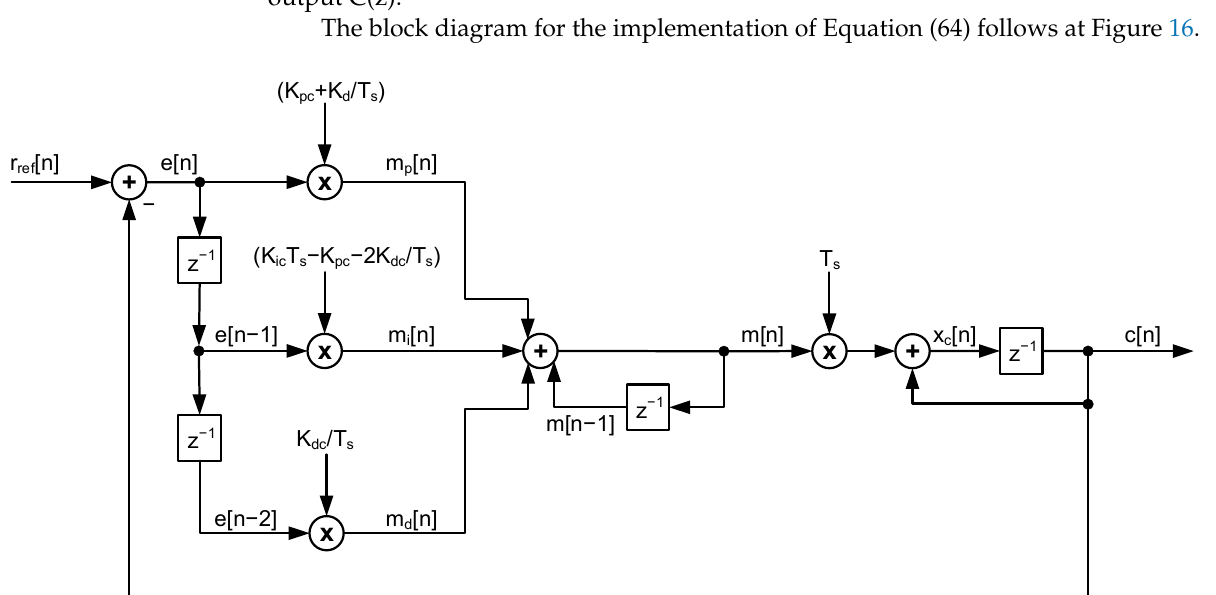
Figure 16. Block diagram for closed loop analysis in discrete time.